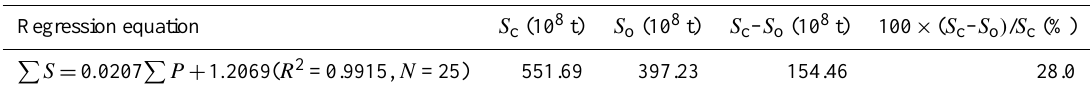
Table 5. Linear regression equations between cumulative sediment discharge and cumulative precipitation for the period before the transition years in the MRYR basin.